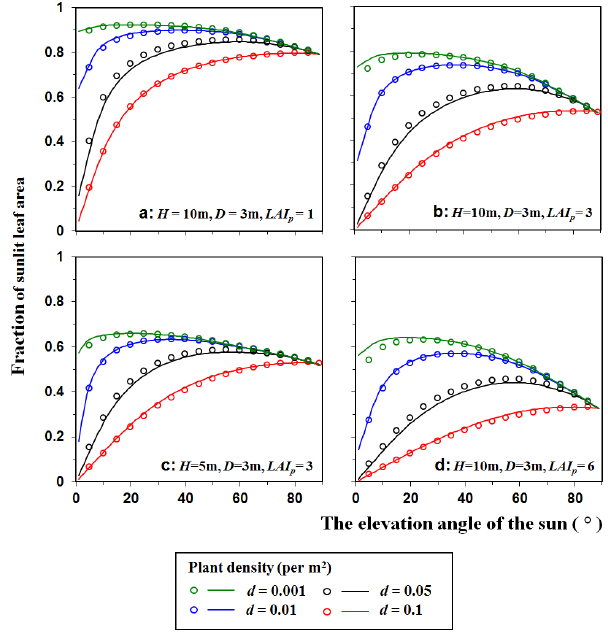
Figure 5. Comparisons of the calculated fractions of sunlit leaf area between the IPR model (curves) and the average of the random approach (circles) for one-stratum plant communities of different heights ( H) , crown width ( D) , local leaf area indices (LAI p ) and plant densities ( d) . Different colours correspond to different plant densities shown in the legend. The top height of crown, crown width and local leaf area indices are shown in the panels. The bottom height of the crown ( h) is 0m. The circles for d = 0.1plantsm − 2 were calculated assuming that plants are distributed regularly be- cause plants cannot be distributed randomly without overlapping in such a dense plant